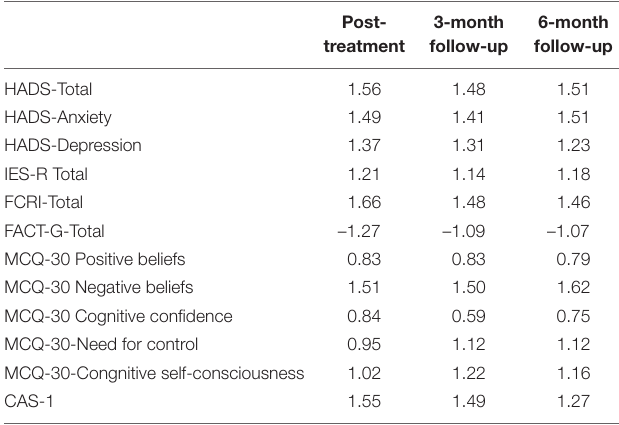
TABLE 3 | Within group effect sizes (Cohen’s d ) for outcome measures at post-treatment and 3- and 6-month follow-up.